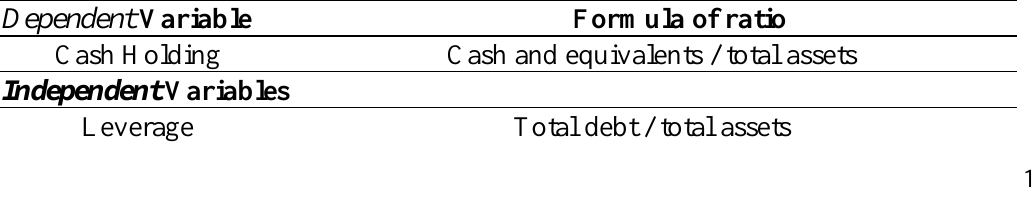
Table 1. Formula of